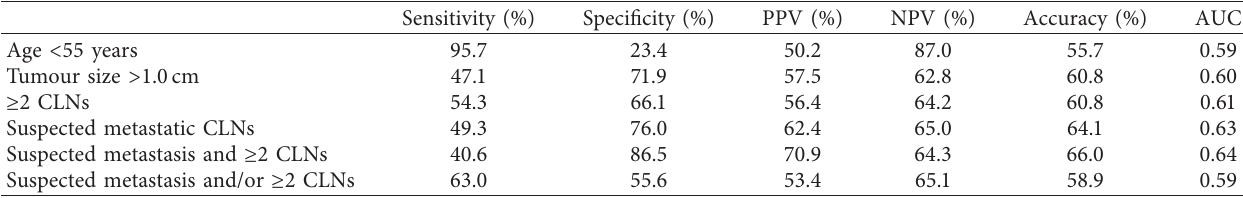
Table 2: Diagnostic efficiency of features for CLNM